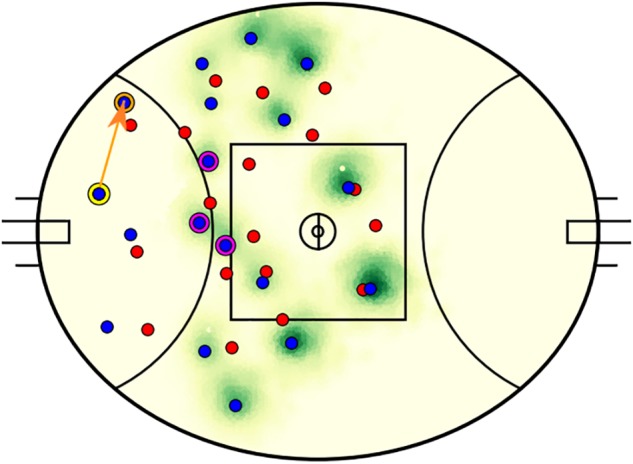
An example output of the decision-making model. The attacking team players are plotted in blue and their opponents in red. The kicker (circled in yellow) executed a pass along the orange line to the receiver (circled in orange). The model identified three higher valued passes (to players circled in magenta) toward the middle of the field that are within a 60 m radius of the kicker. The intensity of green correlates to the expected outcome of passes to each field position.